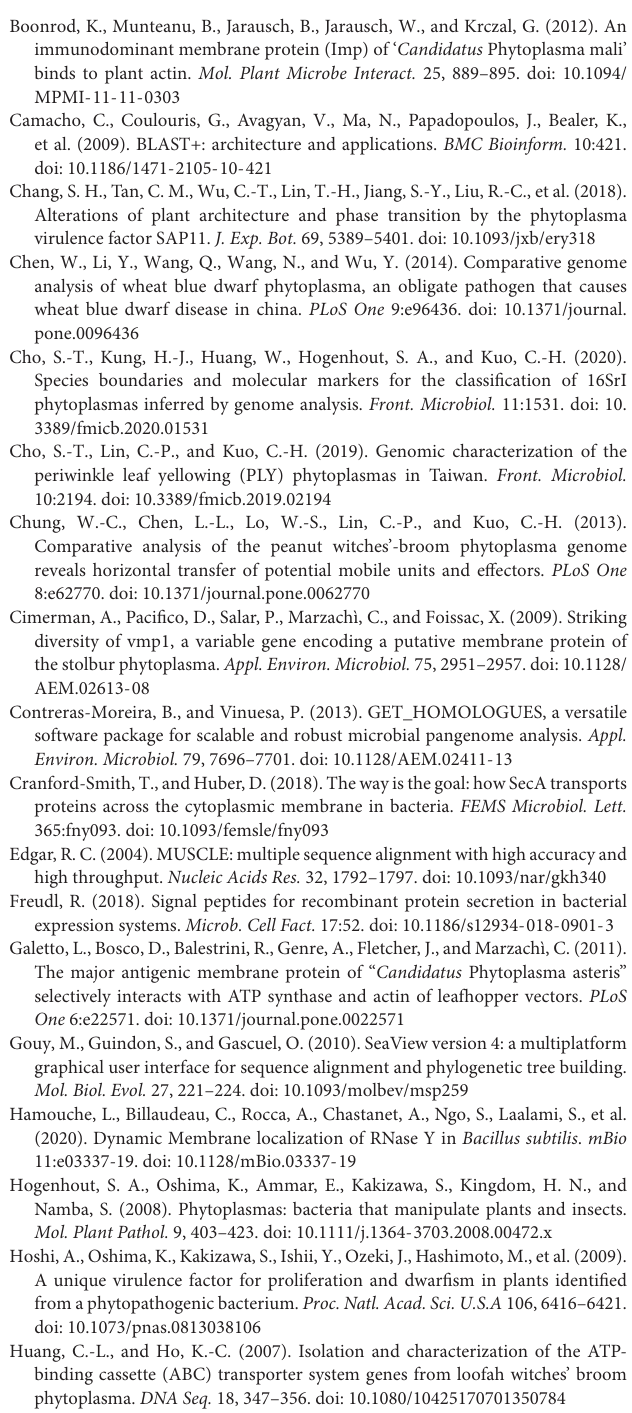
Supplementary Table 12 | Accessions related to VmpA, VmpB, and Vmp1, and the associated signal peptide predictions. Positive signal peptide predictions were indicated with “Y,” and negative ones with “N” and a gray background for enhanced visibility. Supplementary Table 13 | List of Imp accessions used in this study. Supplementary Material 1 | Sequences used in this study, grouped as fasta